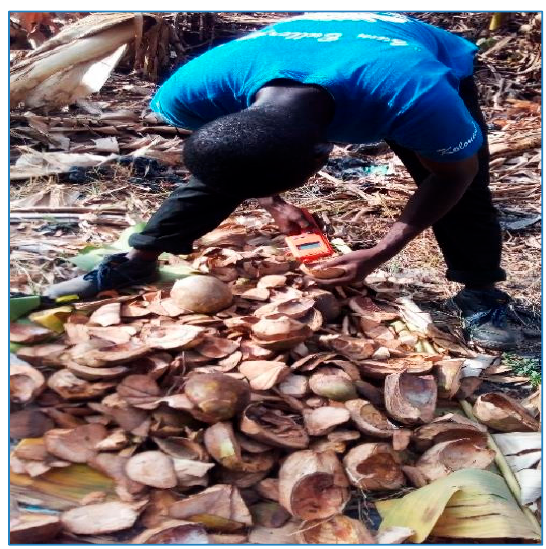
Figure 3. Field measurement of moisture content using the moisture meter.